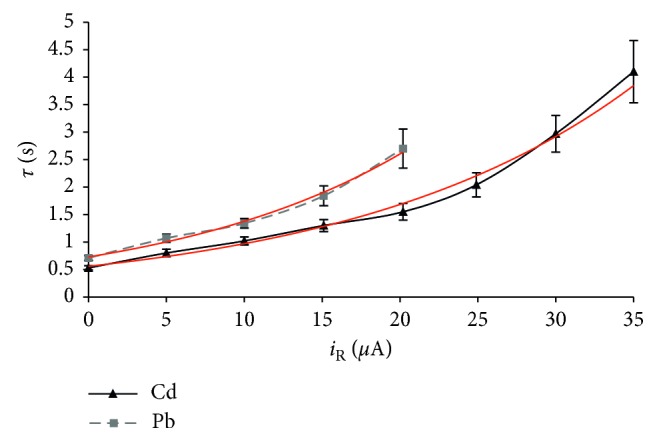
Influence of the reduction current on the oxidation time (mean value ± 2SD, n=5; cm = 40 μg/L; Q = 13.2 ml/min; tdep = 120 s; trp = 60 s).